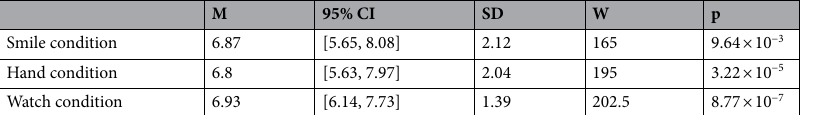
Table 2. Statistics of the Wilcoxon rank-sum test with a chance level under each condition for “autonomy of android”.